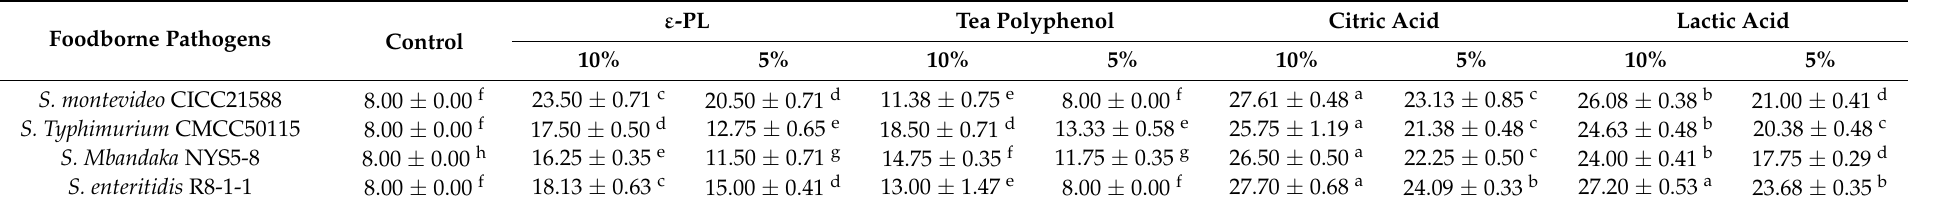
Table 3. Antimicrobial activity of ε -PL, tea polyphenol, citric acid and lactic acid against 4 Salmonella strains using the oxford cup